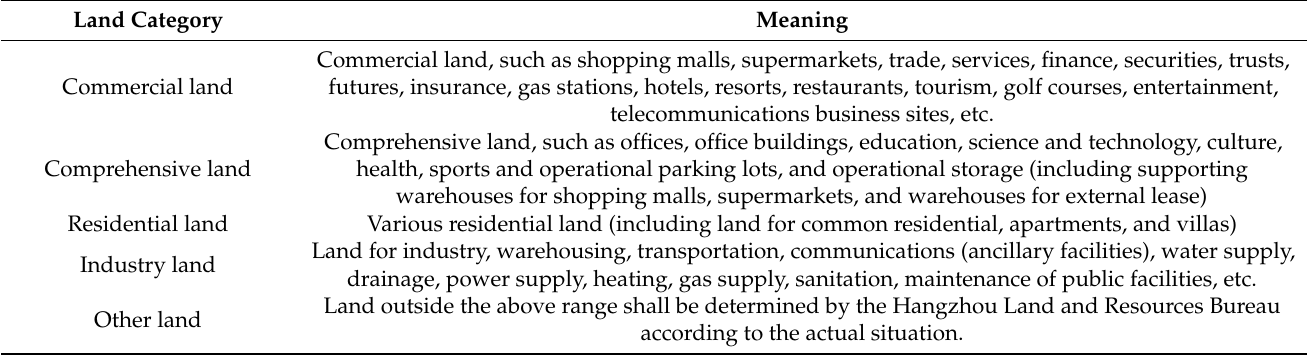
Table 4. Classification table of urban land use in Hangzhou in 2005.